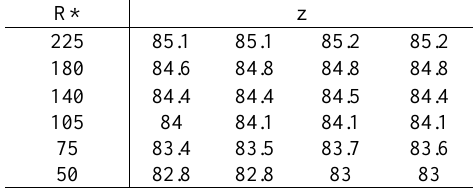
Table 3. Values of piezometeric pressure in different levels (z) for the depth of 85